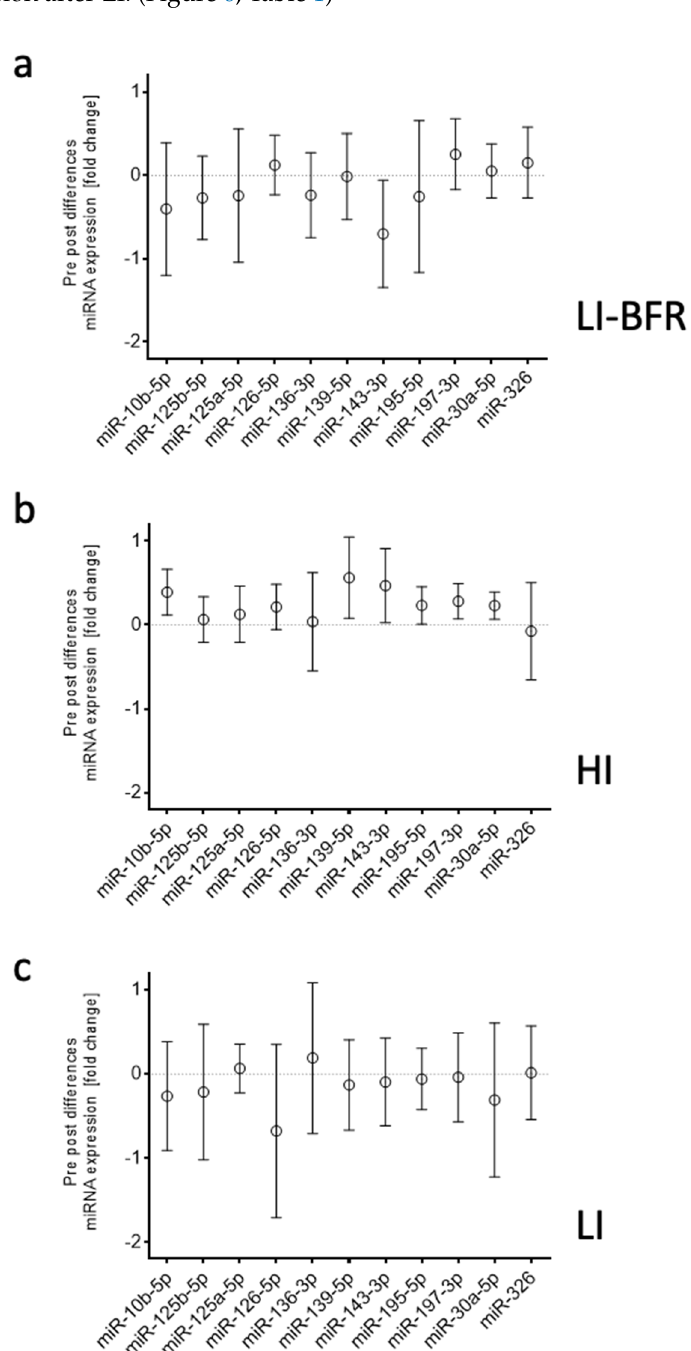
Figure 6. Di ff erences in miRNA expression pre- and post-training. Data are displayed as mean and 95% confidence intervals. ( a ) LI-BFR, low-intensity training with blood flow restriction. ( b ) HI; high-intensity training. ( c ) LI, low-intensity training.